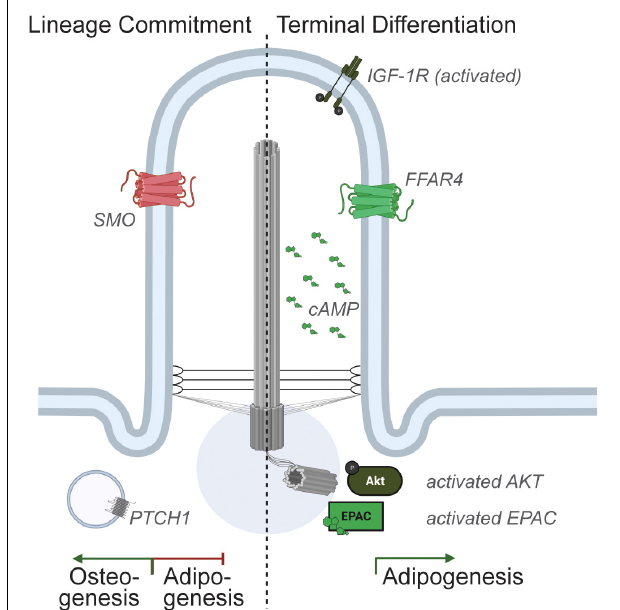
FIGURE 2 | Ciliary signaling in pre-adipocytes. Multiple receptors localize to the pre-adipocyte primary cilium and activation of ciliary signaling pathways can either promote or inhibit adipogenesis. Specifically, Hedgehog signaling has been shown to inhibit MSC commitment to adipogenesis. In contrast, the ciliary IGF-1 receptor and ciliary FFAR4/GPR120 are expressed in committed pre-adipocytes, and activation of these ciliary signaling pathways promotes